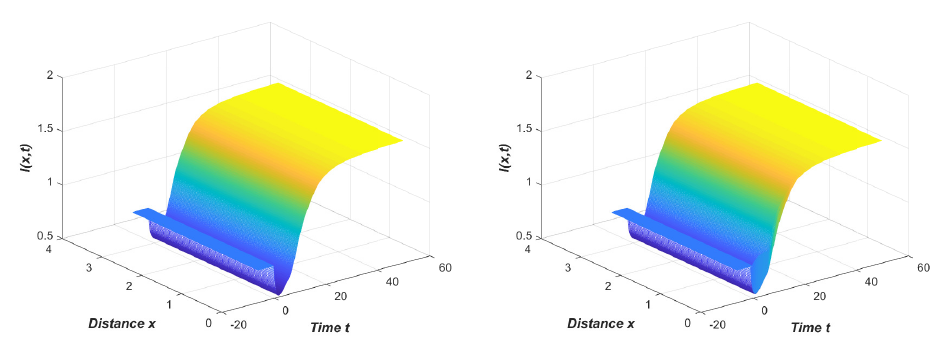
Figure 4. Comparison of compartment I at D = 0 and D = 300.